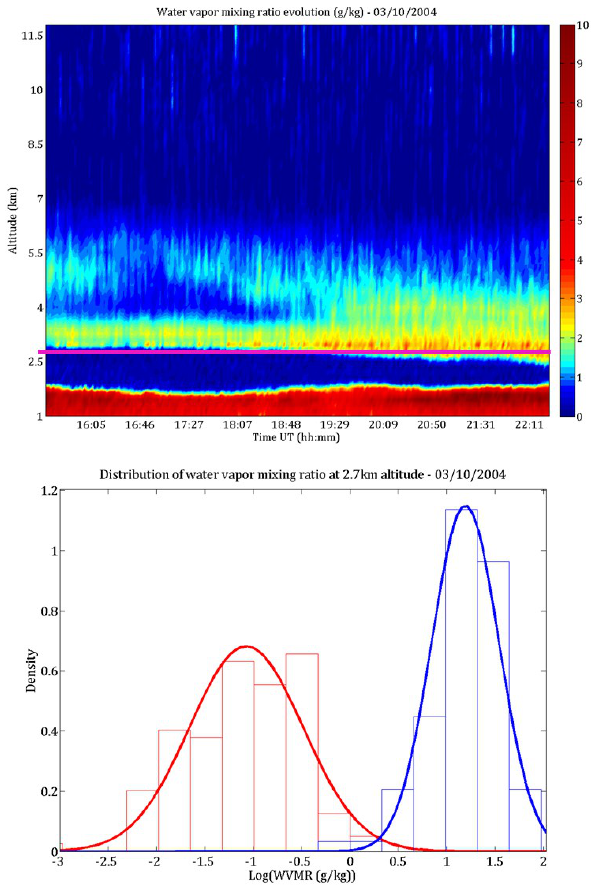
Fig. 8. Evolution of water vapour mixing ratio to 3 October 2004 (top panel). Pink dotted line represents an example of location (here at 2.7km altitude) where the distribution of water vapour are bimodal (bottom panel). On the right panel, red line represents the water vapour distribution before 19:30UTC and the blue line the distribution after 19:30UTC.